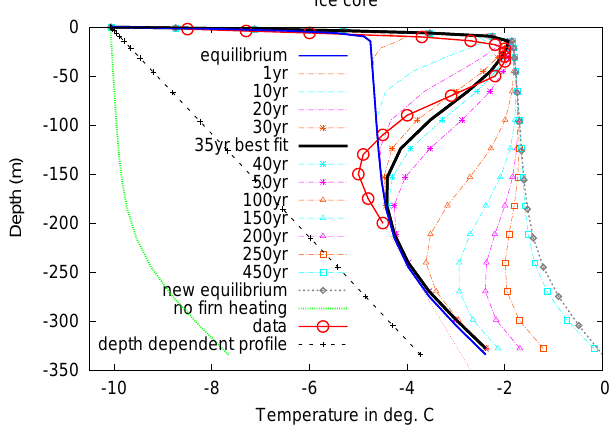
Figure 9. Basal temperature field ( ◦ C, relative to pressure melting, 1995): adding of firn heating (simulation firnss ). This figure remains unchanged whether the non-equilibrium part (simulation firnevol ) of the firn heating is added or not. The position of the ice core is indicated in red, the position of the two locations used in Fig. 7 in white. The firn line is drawn in purple, the 20m ice thickness iso- line in light grey. The latter is a good indicator for underestimated ice thickness in areas where fast sliding seems to be in strong con- tradiction with too cold basal